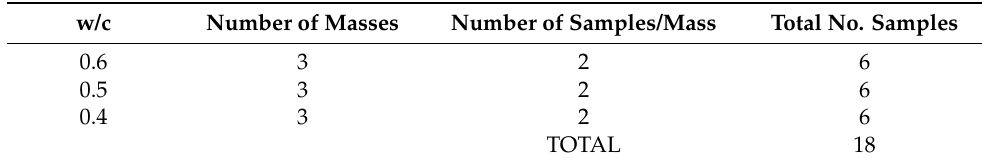
Table 2. Table summarizing the number of samples per dosage.